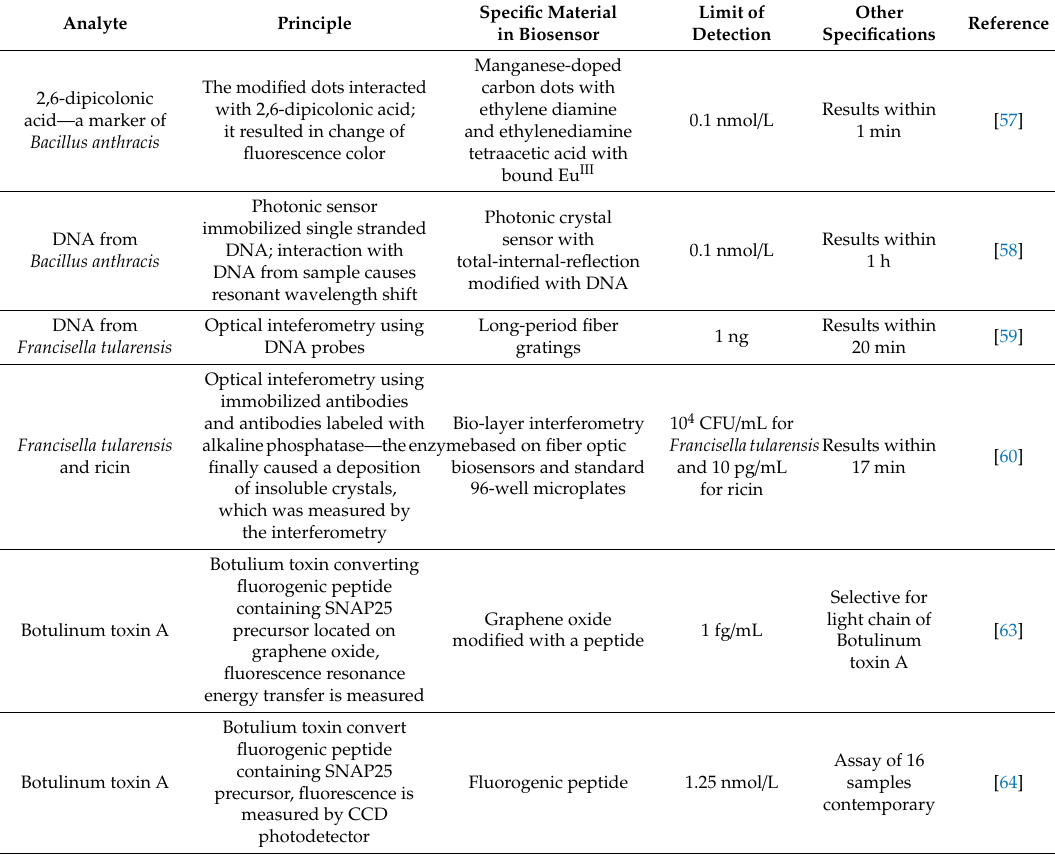
Table 2. Optical biosensors and bioassays for biological warfare agents